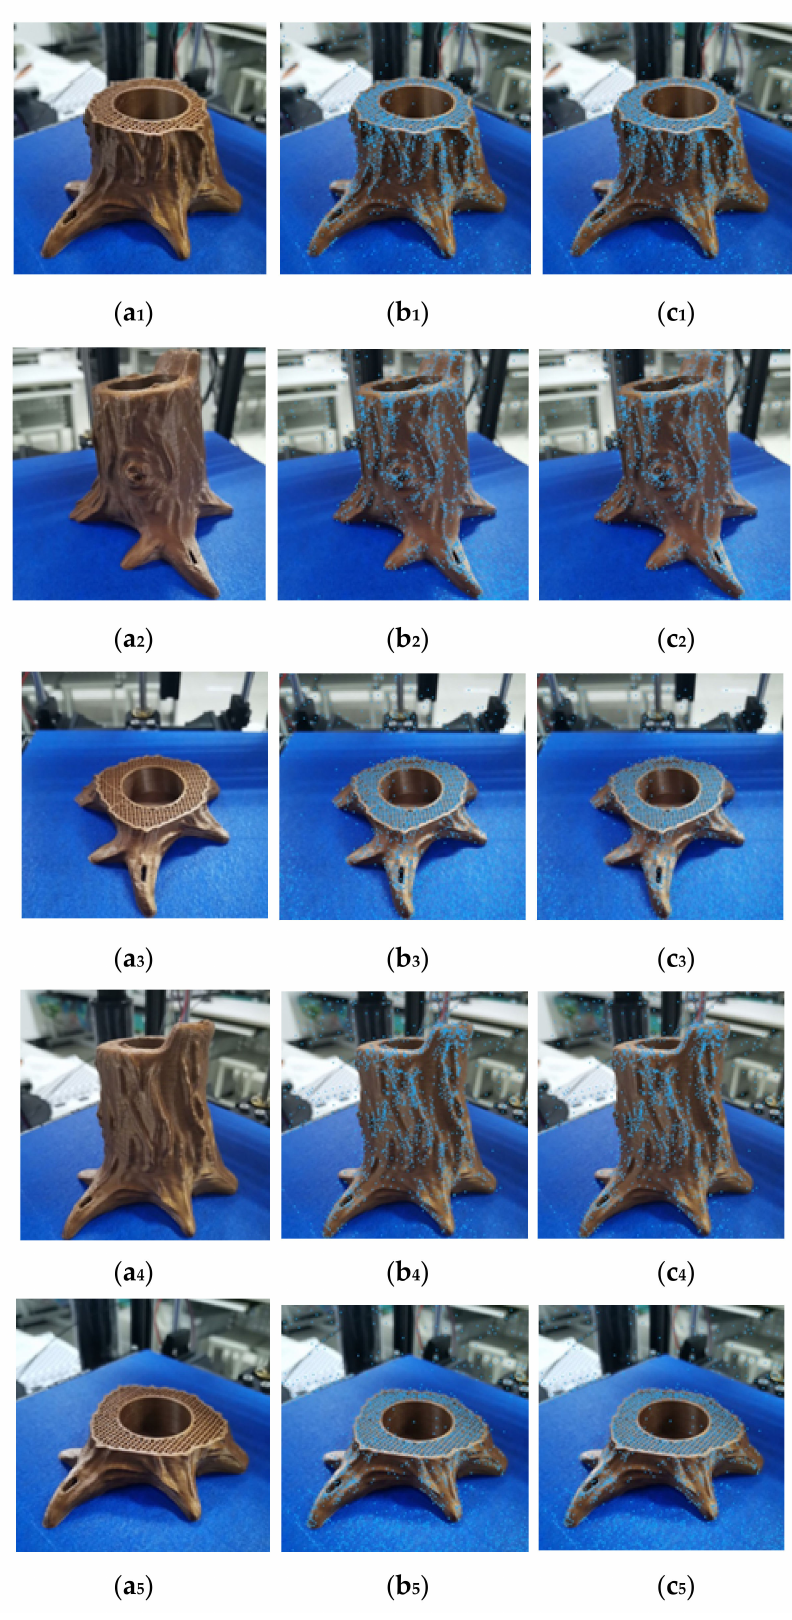
Figure 7. Comparison of the feature point extraction results in the printing process. ( a 1 – a 5 ) The original image of the printing process; ( b 1 – b 5 ) The feature point extraction of the traditional SIFT algorithm; ( c 1 – c 5 ) The feature point extraction of the FFT-SIFT